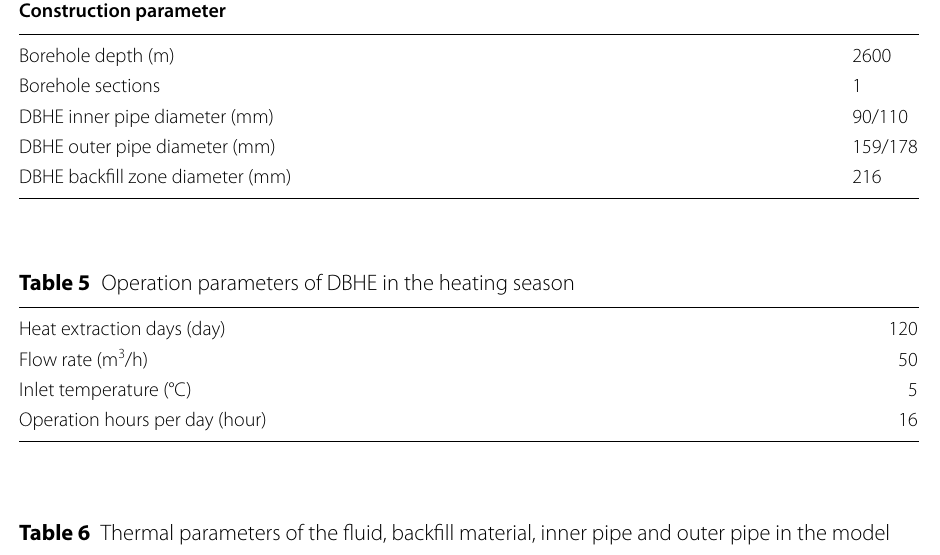
Table 4 Construction parameters of DBHE Construction parameter